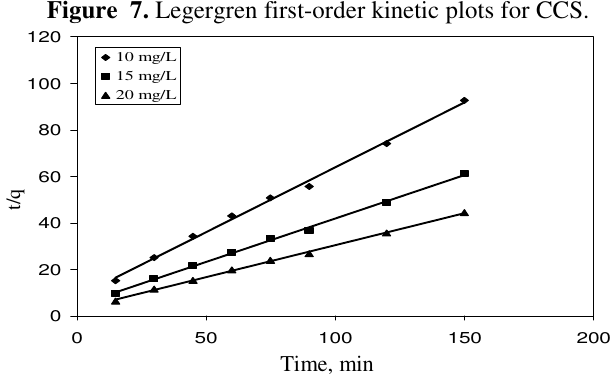
Figure 8. Pseudo second-order kinetic plots for